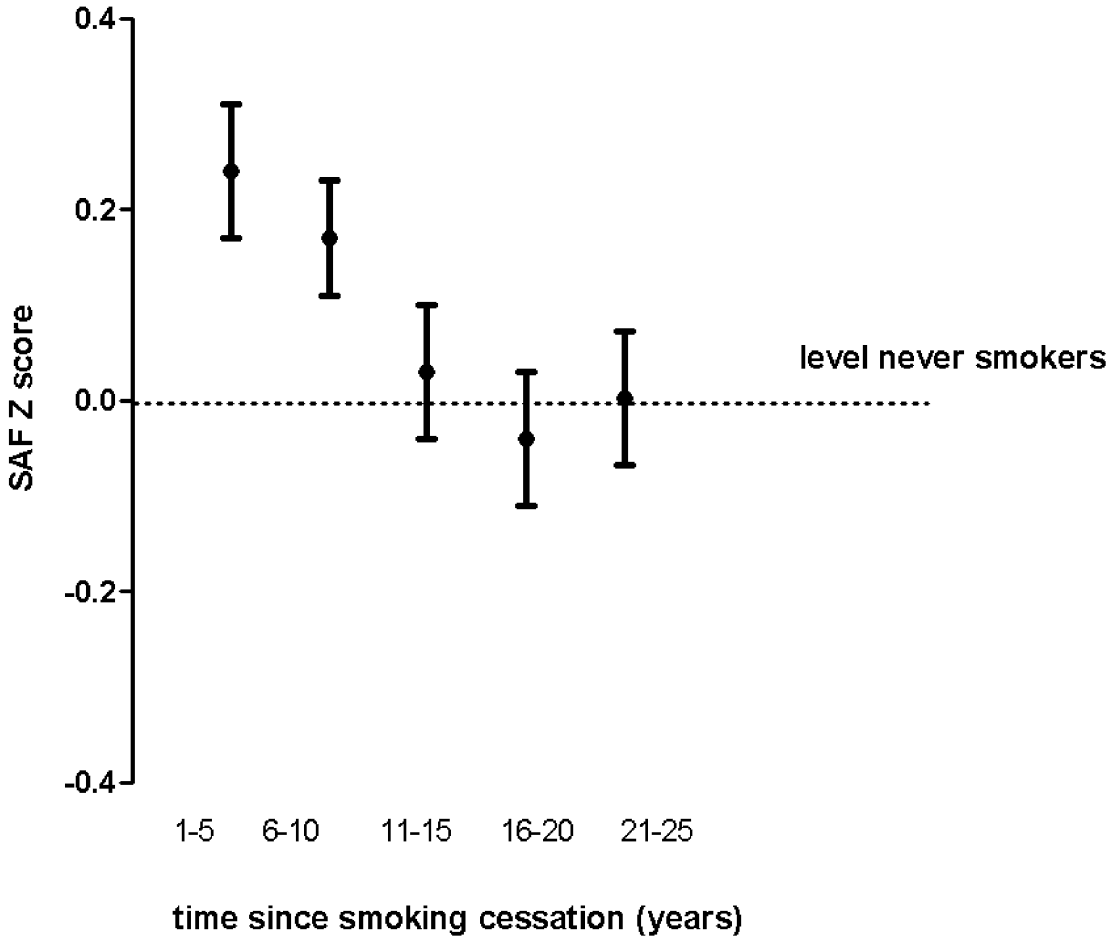
Fig 2. Effect of smoking cessation on skin autofluorescencein former smokersparticipating in the LifeLines study. Dots show mean SAF Z-scores (adjusted for age, BMI, creatinine clearanceand diabetes status). Whiskers reflect standarderror of the mean. SAF, skin autofluorescence